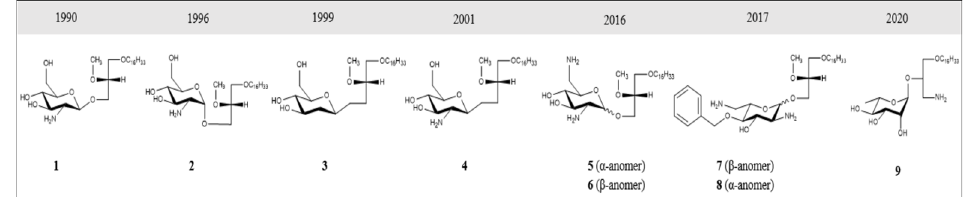
Figure 2. Structural evolution of GAEL prototypes. 1 = α -GLN, 2 = β -GLN; 3 and 4 are C-glycosidic analogs; 5 and 6 incorporate a second amino group at the 6 position; dibasic analogs 7 and 8 with L -glucose; 9 = 3-amino-1-O-hexadecyloxy-2R-(O– α - L -Rhamnopyranosyl)-sn-glycerol ( L -Rham).